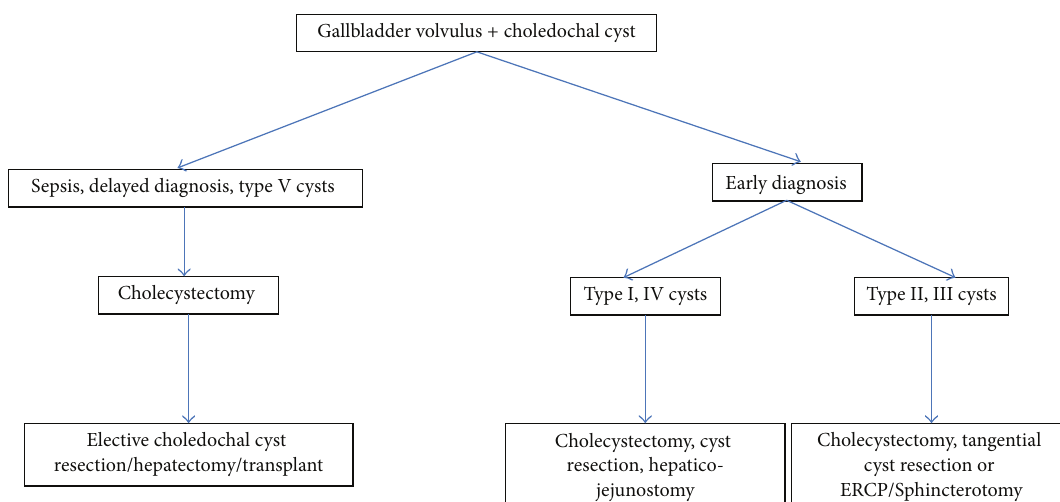
Figure 4: Algorithm for treatment of gallbladder volvulus in patients with concomitant choledochal